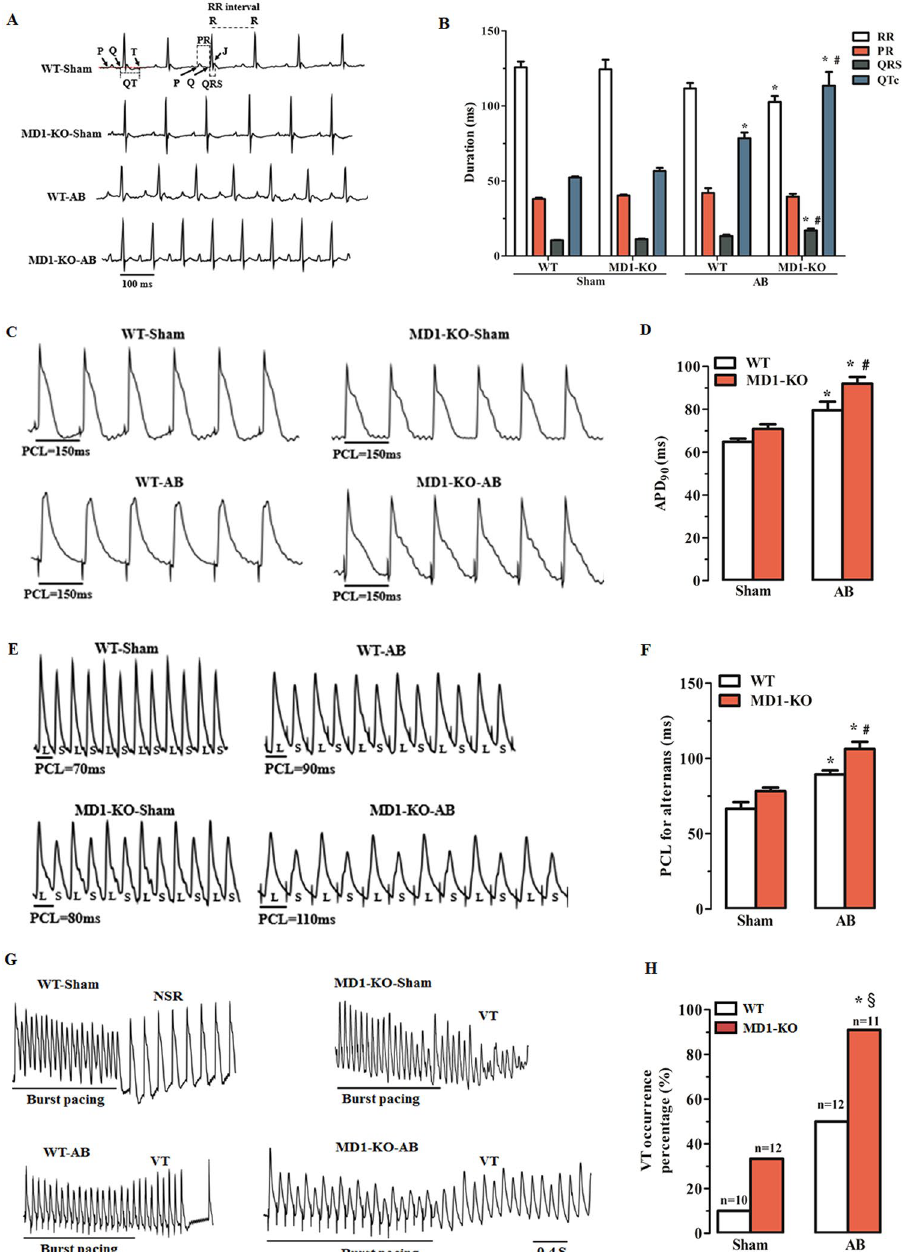
Figure 3. Deletion of MD1 alters surface ECG parameters and exacerbates pressure overload-induced LV electrical remodelling. ( A ) Examples of surface ECG recordings and ( B ) summary of surface ECG parameters from WT and MD1-KO mice at 4 weeks after surgery (n = 7–8). ( C ) Representative MAP recordings at a PCL of 150 ms and ( D ) statistical analysis of APD 90 from Langendorff-perfused WT and MD1-KO hearts at 4 weeks after surgery (n = 8–9). ( E ) Representative MAP recordings of APD alternans and ( F ) statistical analysis of the threshold interval for APD alternans from the indicated groups (n = 7–8). ( G ) Examples of MAP recordings after burst pacing and ( H ) summary of VT inducibility rates in Langendorff-perfused WT and MD1-KO hearts at 4 weeks after surgery (n is indicated above the bar graphs). PCL = pacing cycle length; L = longer APD; S = shorter APD; NSR = normal sinus rhythm. * P < 0.03 vs. WT-Sham, § P < 0.01 vs. MD1-KO-Sham, # P < 0.05 vs.